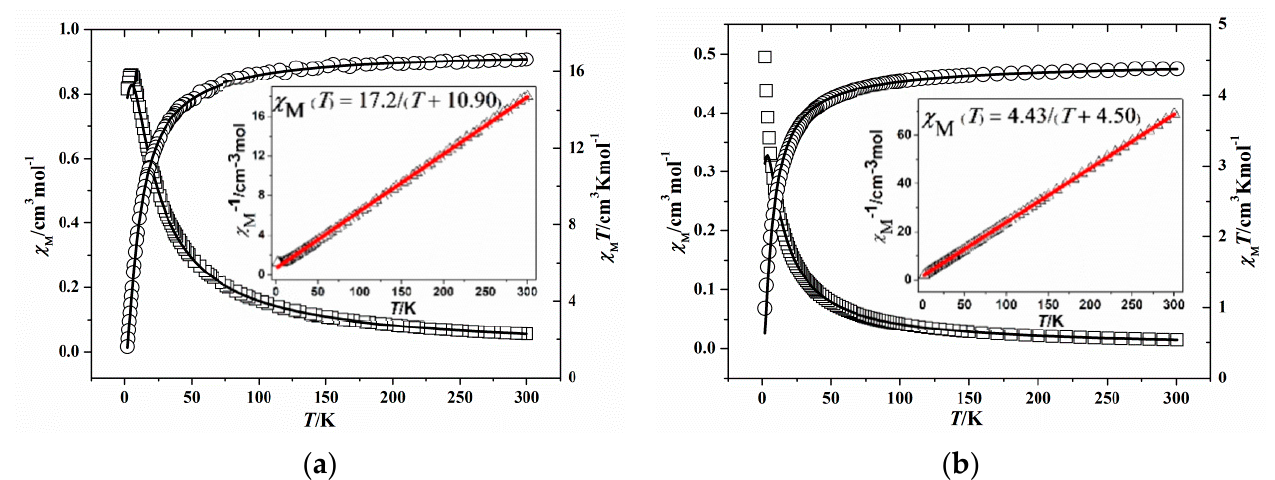
Figure 4. Plots of χ M T ( ) and χ M ( ) versus T for complex 1 ( a ) and 2 ( b ). Inset: the red line represent the best fit of 1/ χ M based on Curie ‐ Weiss law in 2 − 300 K temperature range for complex 1 and 2 , respectively.